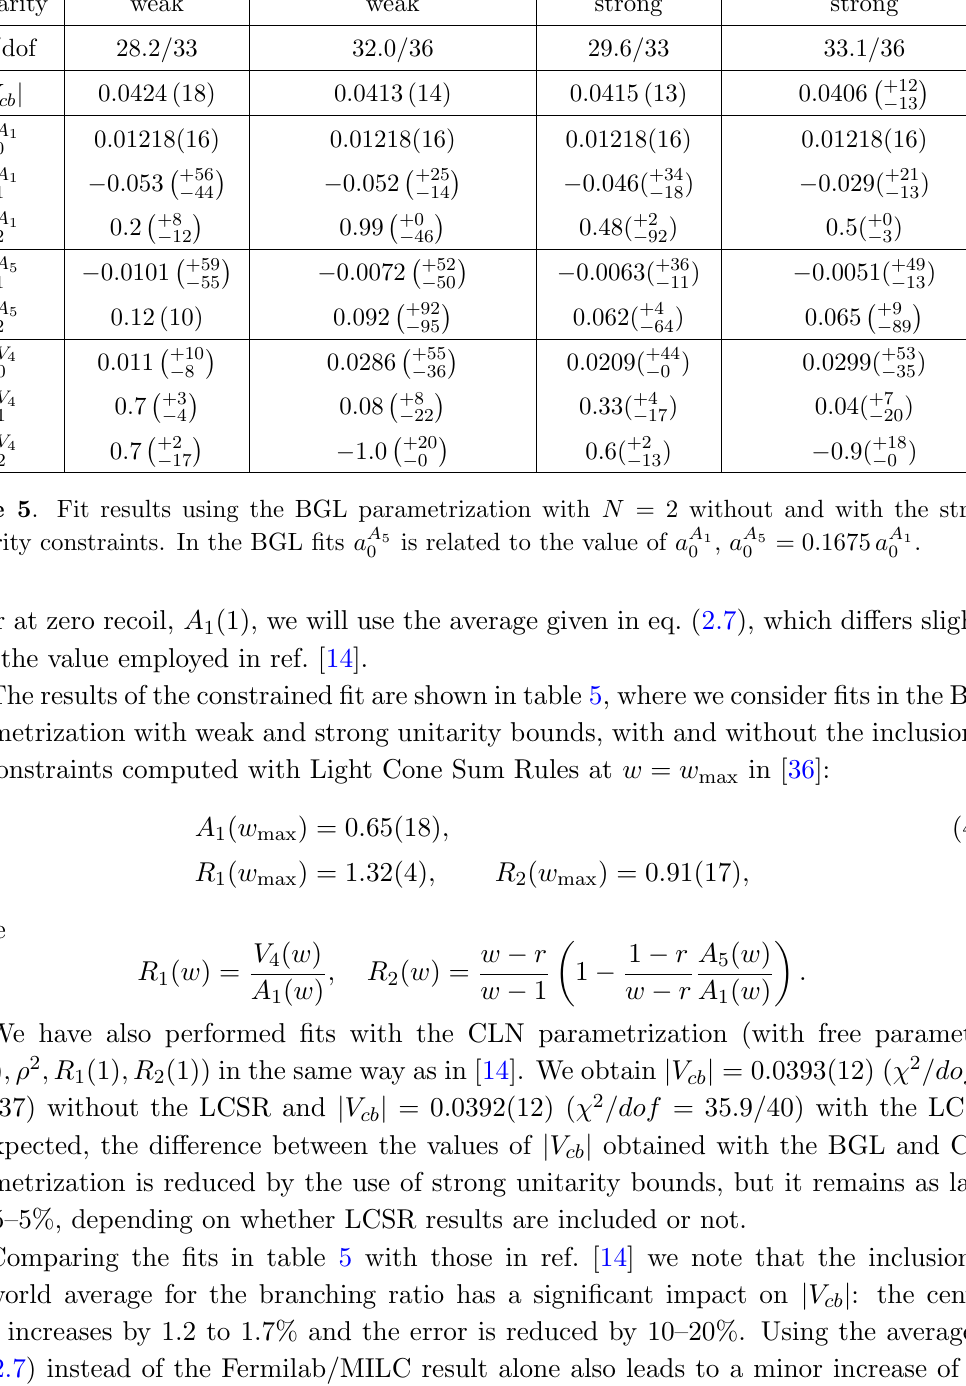
, a A 5 = 0 : 1675 a A 1 0 0 0